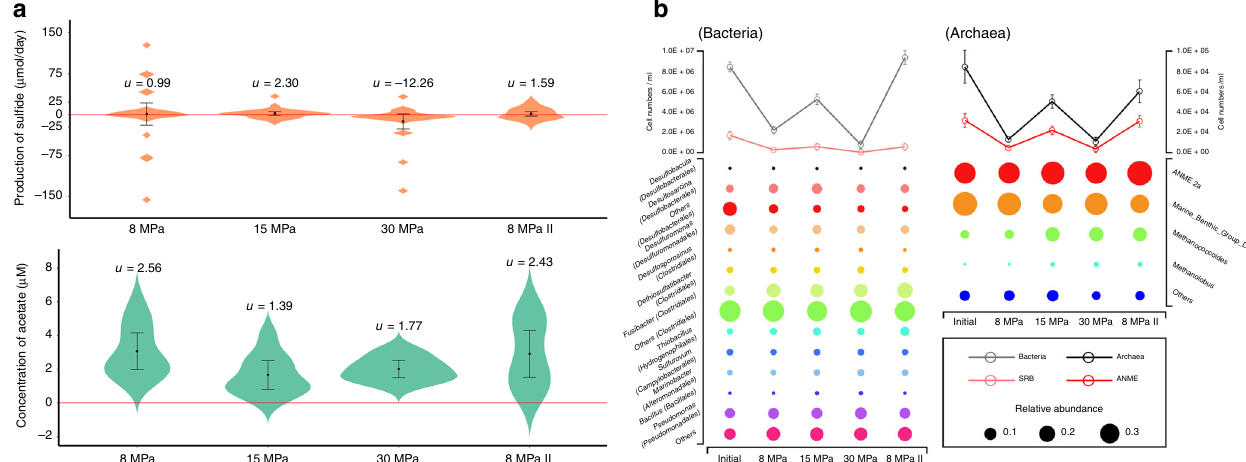
Fig. 1 Activity and community structure in the enrichment. The mean value ( u ) and standard deviation of sul fi de production are calculated based on: n = 27 (8 MPa), n = 28 (15 MPa), n = 25 (30 MPa), n = 28 (8 MPa II). The mean value ( u ) and standard deviation of acetate concentration are calculated based on: n = 10 (8 MPa), n = 10 (15 MPa), n = 9 (30 MPa), n = 10 (8 MPa II). The mean value and standard deviation of cell numbers are calculated based on n =